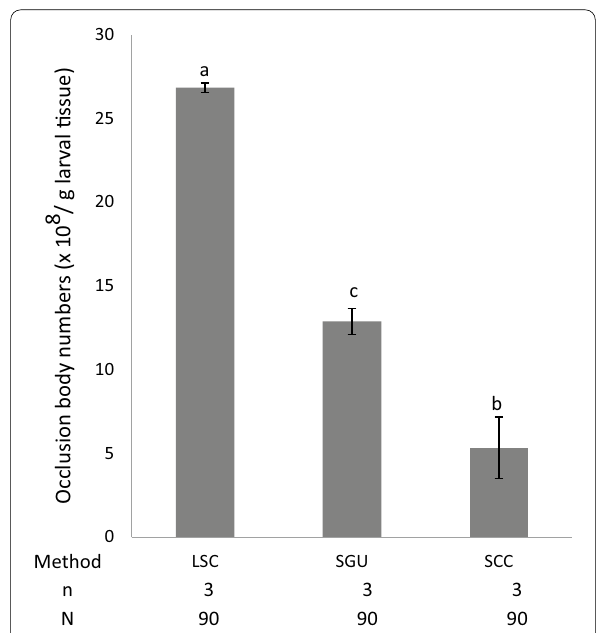
Fig. 2 Occlusion body yield (OB/g) from infected early L4 larvae harvested at 14 days post-infection depending on three purification methods low-speed centrifugation (LSC), sucrose gradient ultracentrifugation (SGU), and sucrose cushion centrifugation (SCC); n and N give the number of independent repetition the number of the tested larva, respectively. Vertical bars indicate the 95% confidential limits. Comparison of means using Student t test: Means with different letters ( a , b and c ) are significantly different at P <